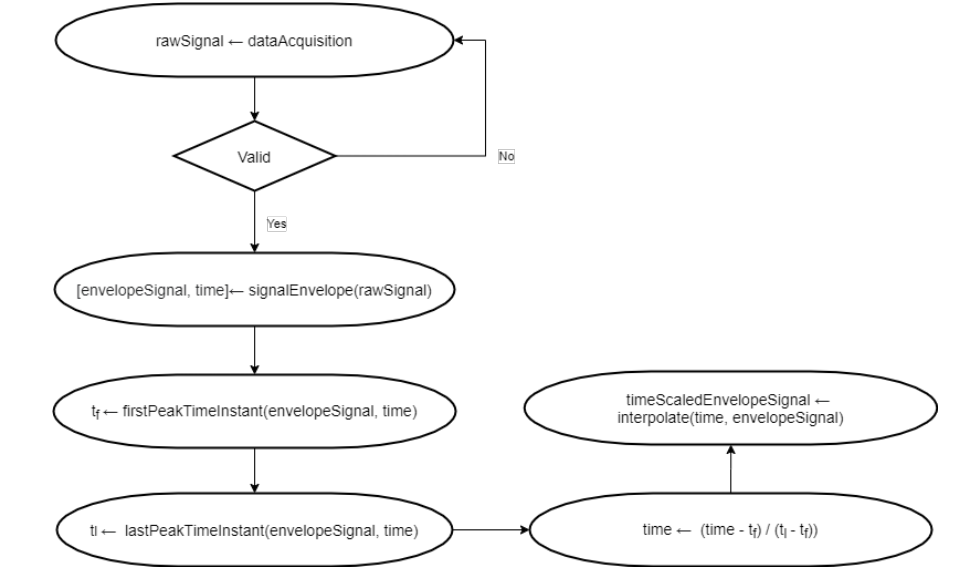
Figure 5. Proposed algorithm for processing the signal.